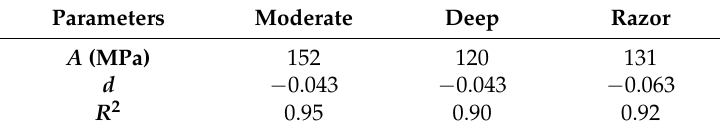
Figure 1. Experimental fatigue data. Modified from Sobieraj et al. [55]. Table 1. S-N Basquin relationship constants. Data taken from